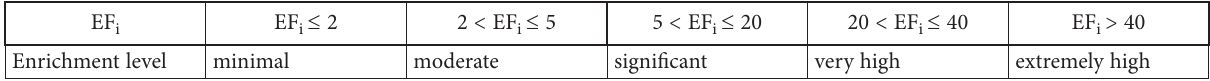
Table 1. Classes of enrichment factor